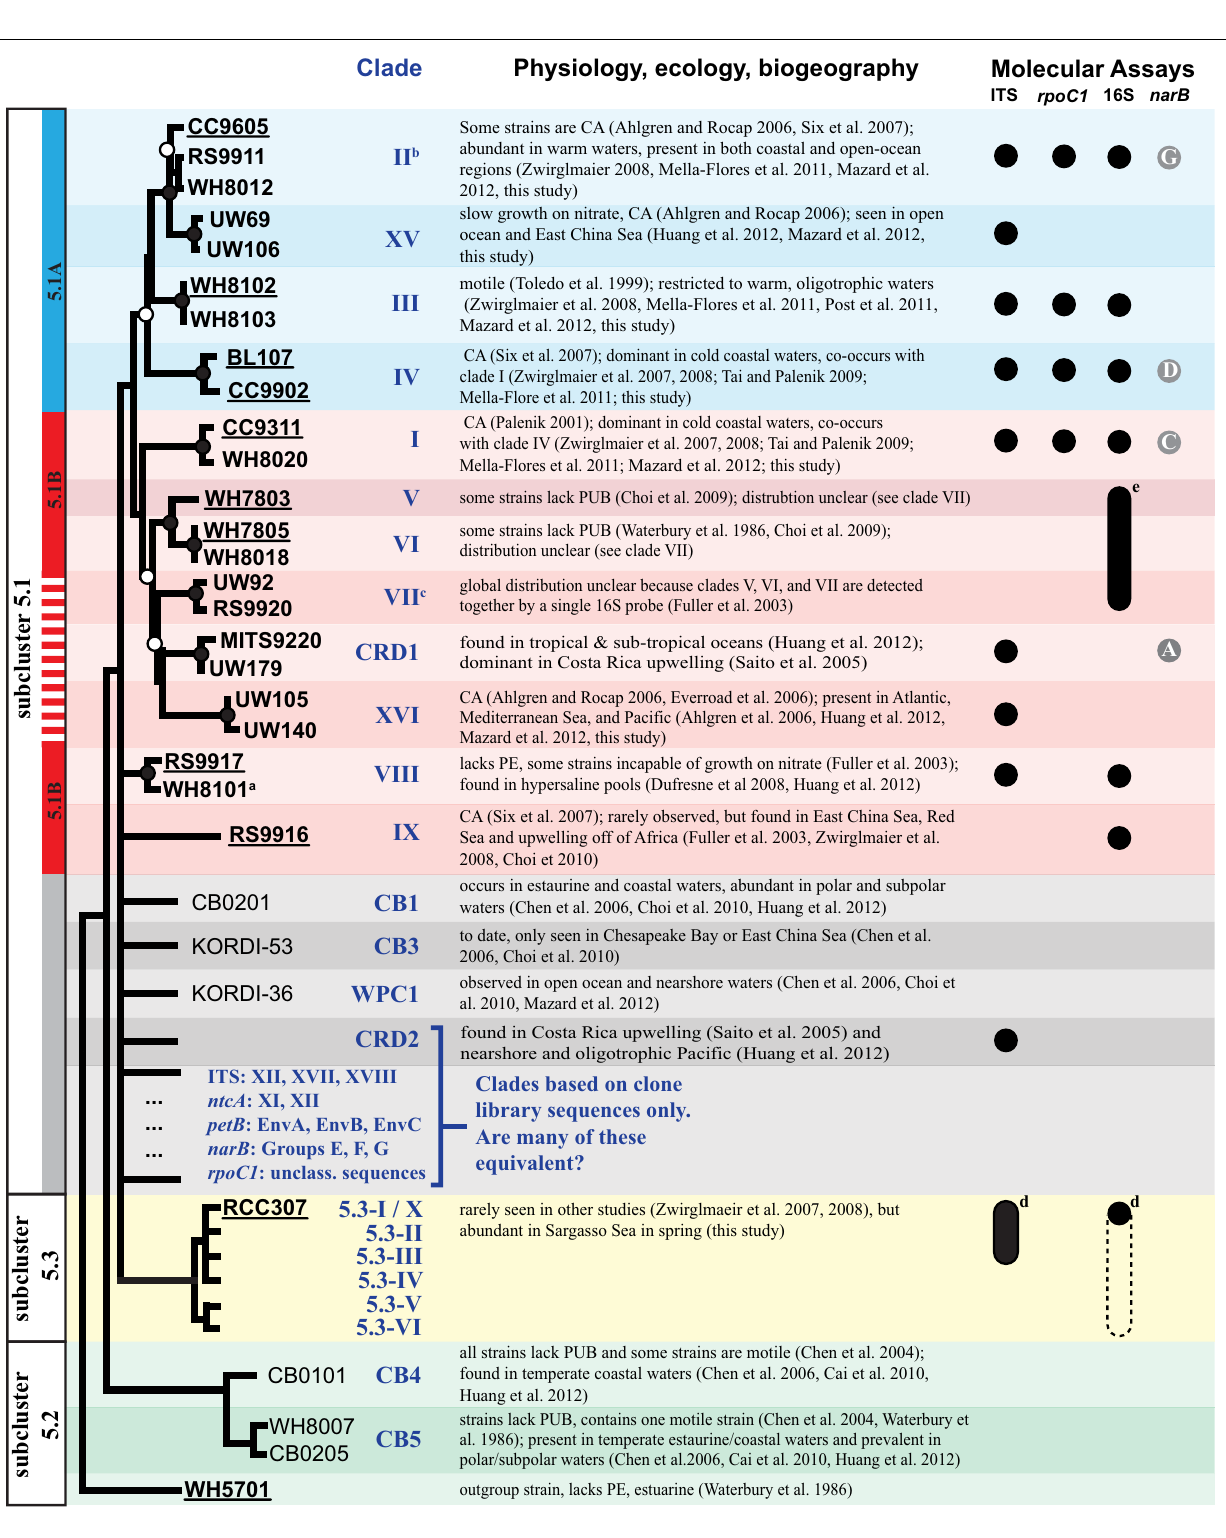
FIGURE 1 | Schematic phylogenetic tree summarizing the genetic and ecological diversity of marine Synechococcus and molecular assays that have been developed to measure particular clades in the oceans. The depicted tree is approximately based on a four loci concatenated tree ( FigureA6 in Appendix). Examples of commonly studied strains (“type”